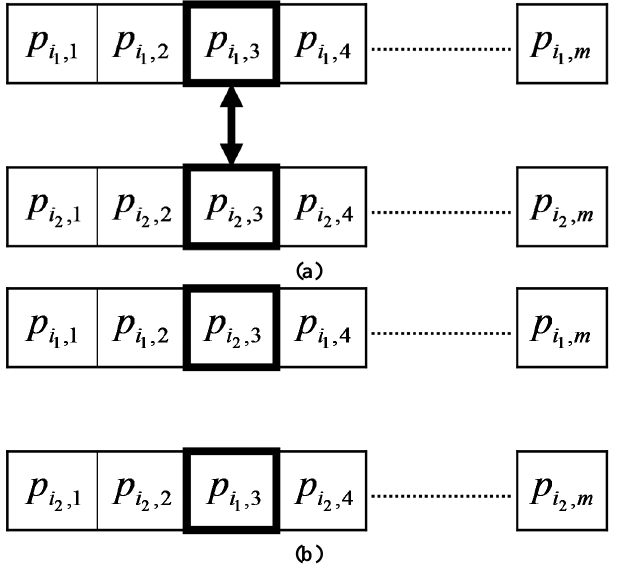
Fig. 1. Scheme of the crossover process: (a) parents; (b) children.